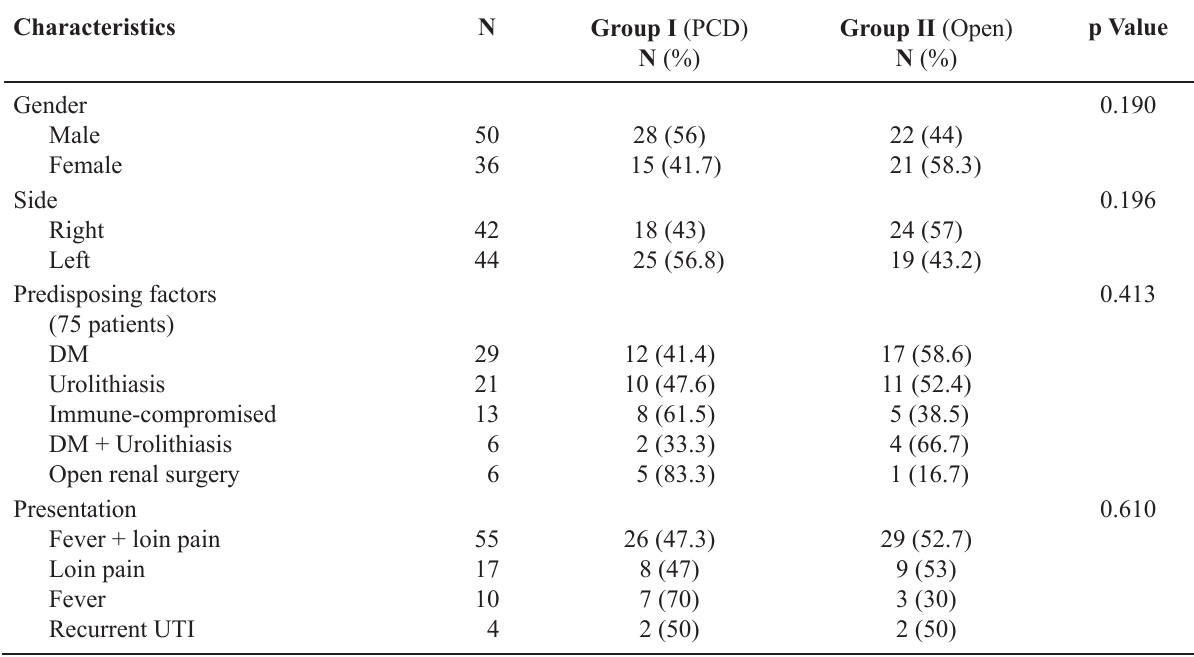
Table 1 – Demographic data of 86 patients with perinephric